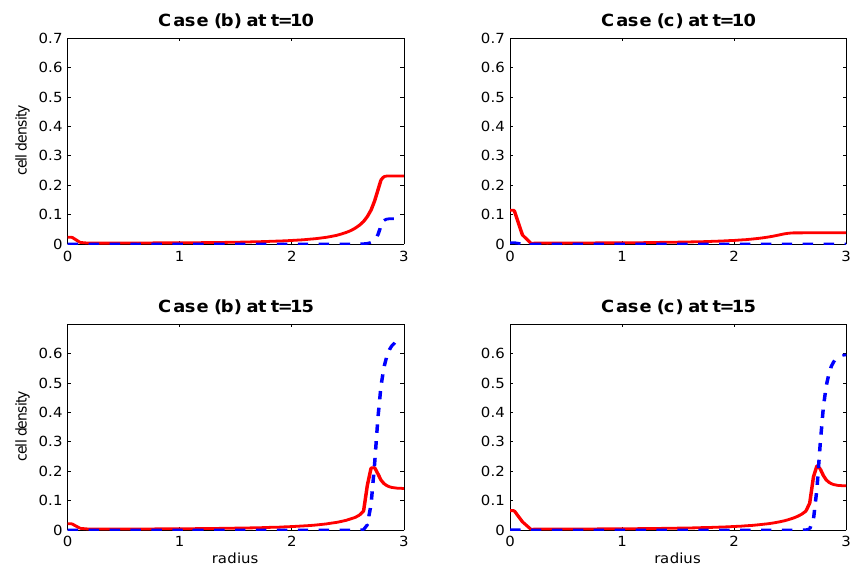
Figure 3. The numerical solutions to (2.1)–(2.2), (2.5) and (2.7) with ρ M started from the initial function (2.6): left-hand side pictures, and from (4.3): right-hand side pictures. Proliferating cells are denoted by solid lines and migrating cells by dashed